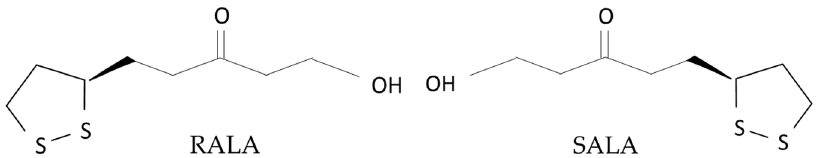
Figure 1. Chemical formulas of RALA and SALA.